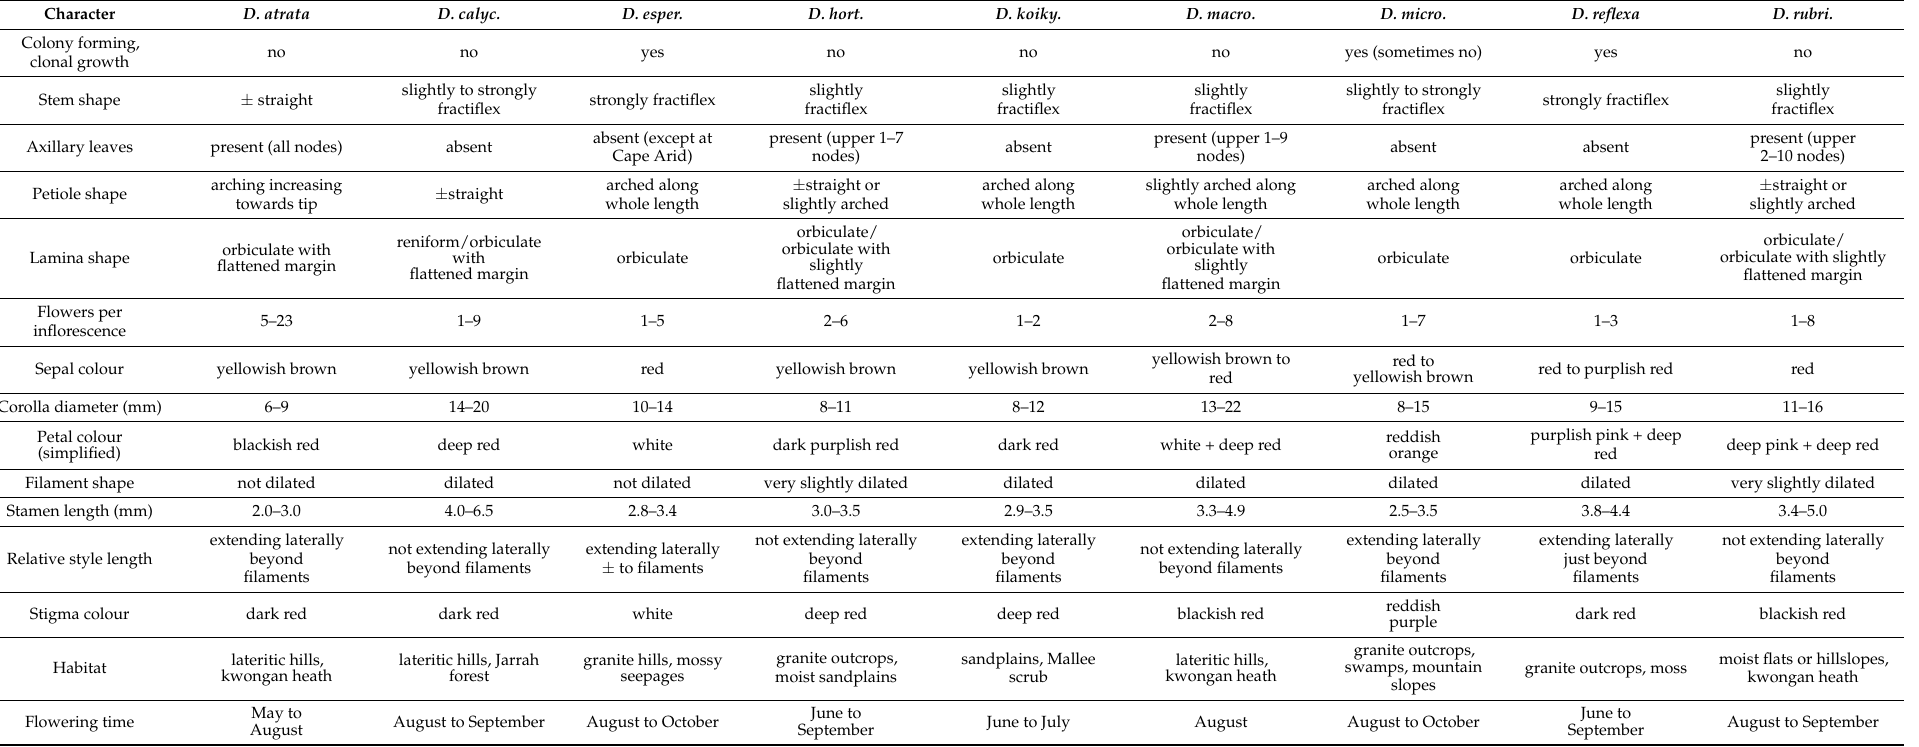
Table 2. Morphological comparison of all nine species of the Drosera microphylla complex. Abbreviations: D. calyc. = D. calycina ; D. esper. = D. esperensis ; D. hort. =